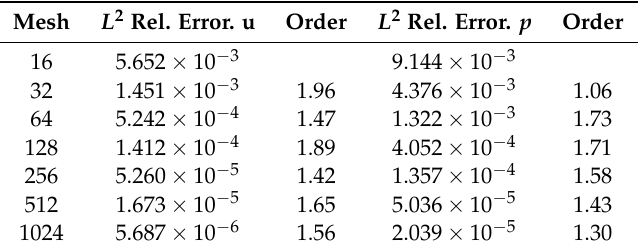
Table 3. L 2 relative errors in space and corresponding orders for the velocity and the pressure—rotational pressure-correction method without correction for the